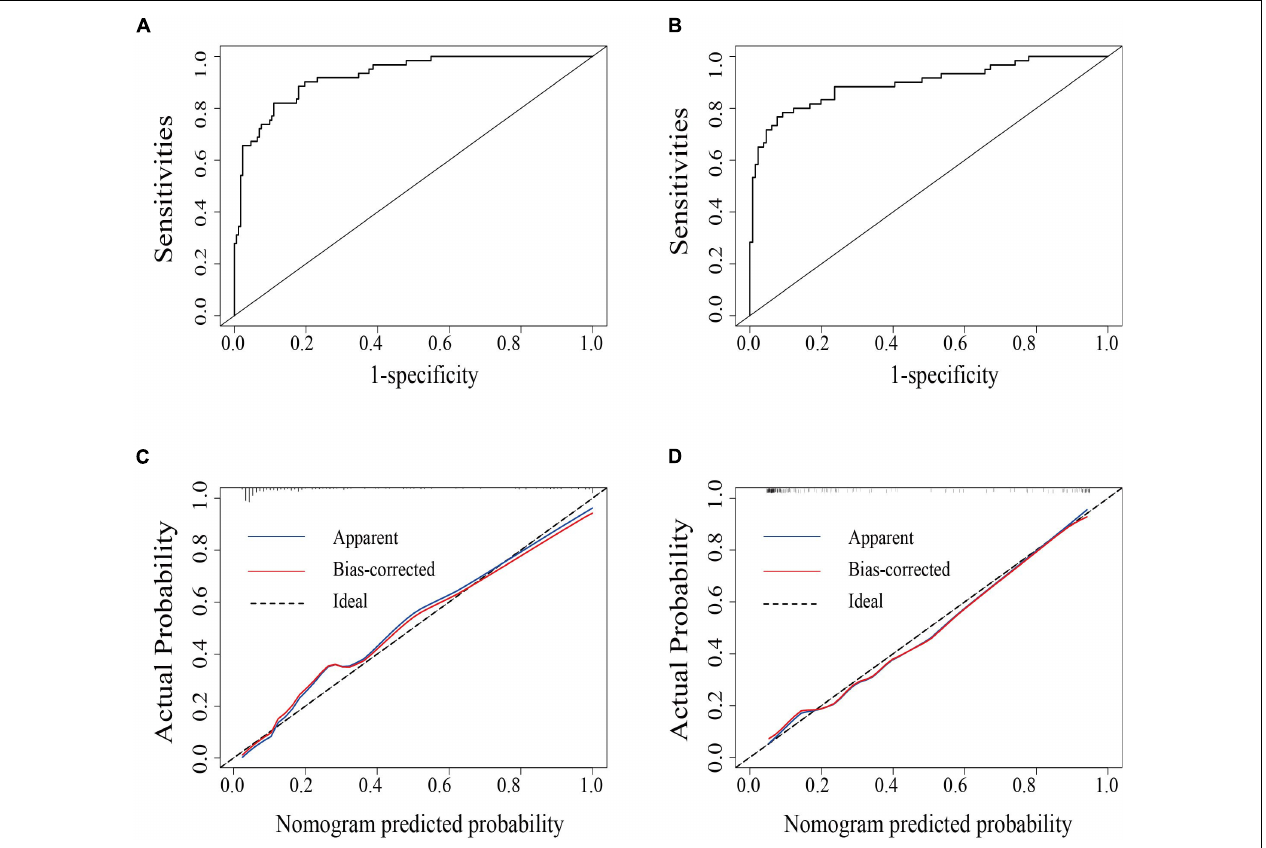
FIGURE 2 | The area under the receiver operating characteristics curve (AUC-ROC) of the model in the primary (A) and the validation cohort (B) , respectively. Calibration curves of the nomogram for the primary (C) and validation cohort (D) .